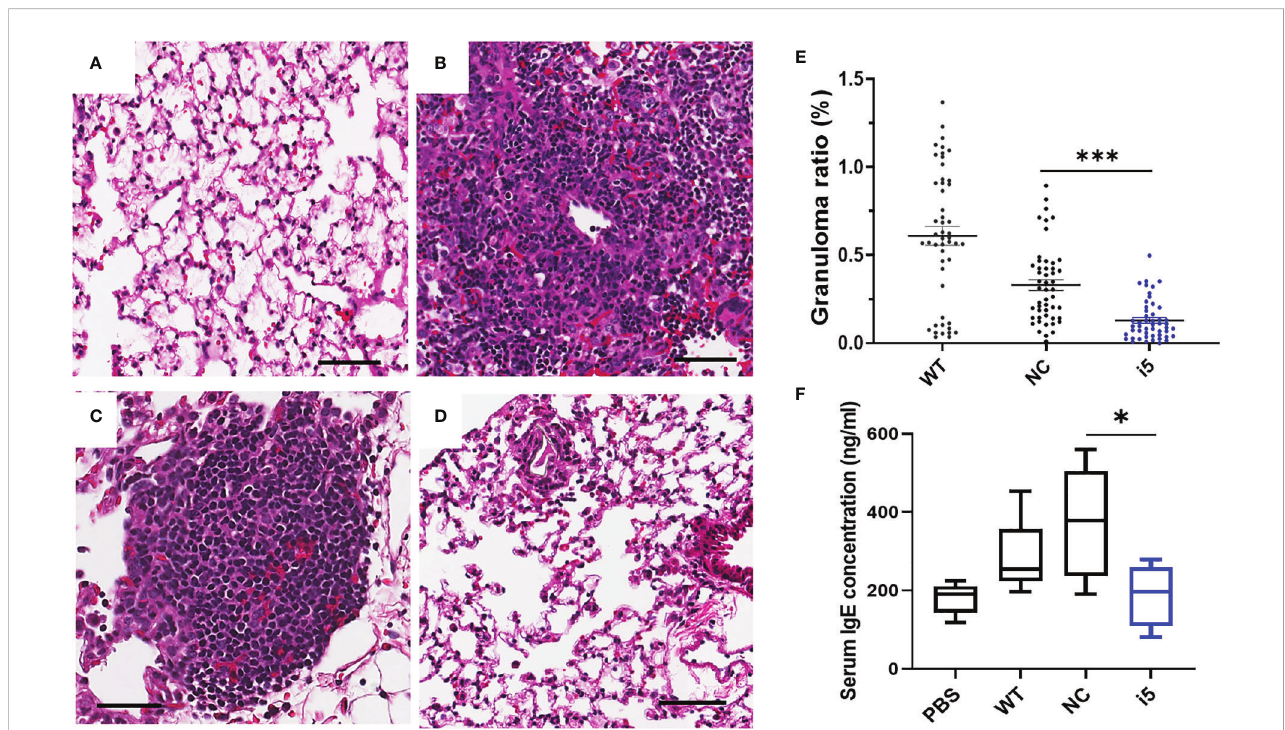
FIGURE 6 Reduced granulomatous in fl ammation and serum IgE levels in mice infected with SmfgfrA -repressed schistosome eggs. Representative digital microscopic images showed (A) lung from mouse injected with PBS and granulomas in lungs from mice injected with (B) WT eggs, (C) NC-treated or (D) i5-treated eggs. All sections were H&E stained. Scale bars in (A – D) = 50 µm. (E) Effect of SmfgfrA -repressed eggs on granuloma formation in the lungs of mice injected with i5-treated eggs. Mice in control groups were infected with untreated WT eggs or NC-treated eggs. Granuloma ratio in each lung section was calculated by dividing the total granuloma size with the lung size X100. Each group included 5 mice and 10 sections per lung were measured (n=50). All data are shown as the mean ± SE. (F) Total serum IgE level in mice 2 weeks after i.v. injection of i5-treated eggs. Mice injected with PBS, WT eggs or NC-treated eggs served as controls. * p value ≤ 0.05, *** p value ≤